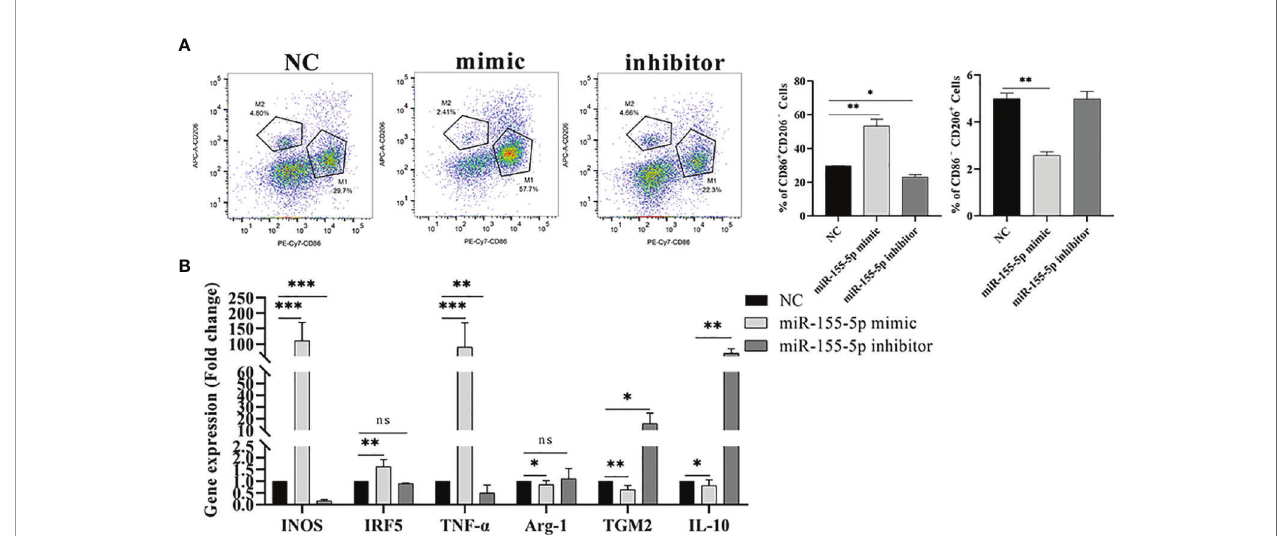
FIGURE 6 | Regulation of macrophage polarization by miR-155-5p. (A) CD86 + CD206 − and CD86 − CD206 + positive macrophages were detected by fl ow cytometry, and the percentage of CD86 + CD206 − M1 and CD86 − CD206 + M2 macrophages was quanti fi ed. (B) The expression levels of characteristic genes of M1 and M2 macrophages in Raw264.7 cells treated with miR-155-5p mimics and inhibitors were analyzed by qRT-PCR. ns ( p ≥ 0.05), * p < 0.05, ** p < 0.01, *** p <